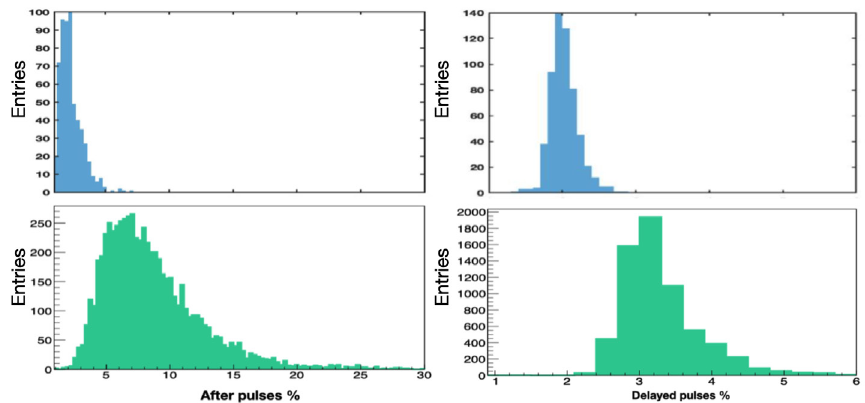
Figure 2: Measurements of the rate of delayed pulses and after pulses for a set of 500 PMTs R14374 (top row) and, for comparison, for the R12199 model as reported in[5].